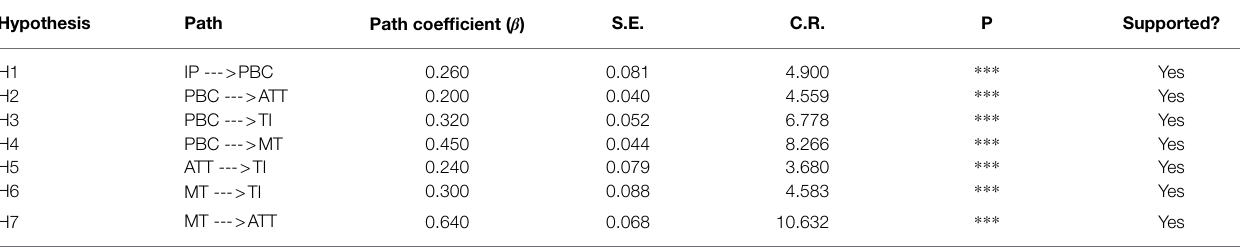
TABLE 6 | Outcomes of structural equation modeling analysis ( N = 470). Hypothesis